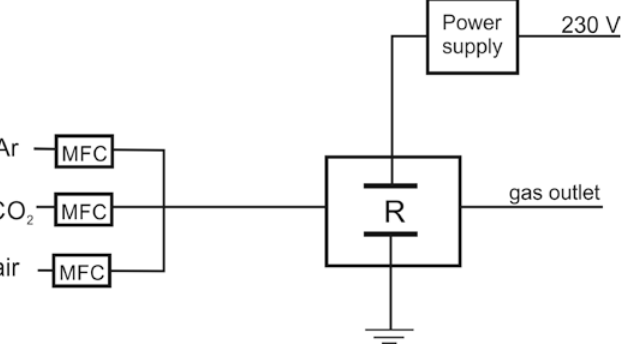
Figure 1. The scheme of the system for polylactide (PLA) membrane modification. The reactor had a porous, metal grounded electrode, on which a modified membrane was placed. The dielectric was located on the high-voltage electrode. The discharge gap was 3 mm wide (Figure 2). The reactor was supplied with a multipulse alternating current of 30 kHz for 4 ms with an 8 ms interval. The average discharge power varied in the range of 10–50 W.